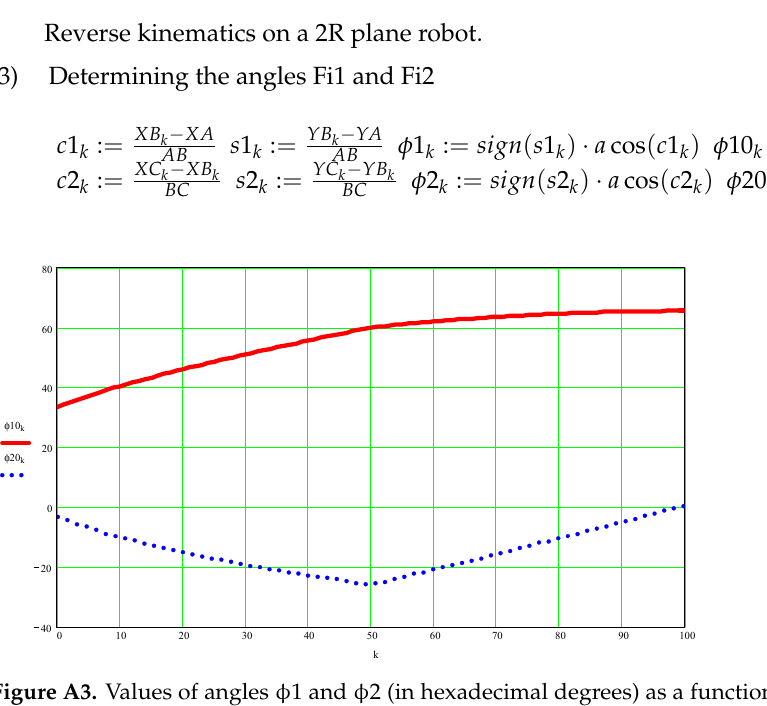
Figure A3. Values of angles φ 1 and φ 2 (in hexadecimal degrees) as a function of the independent variable k. Reverse kinematics on a 2R plane